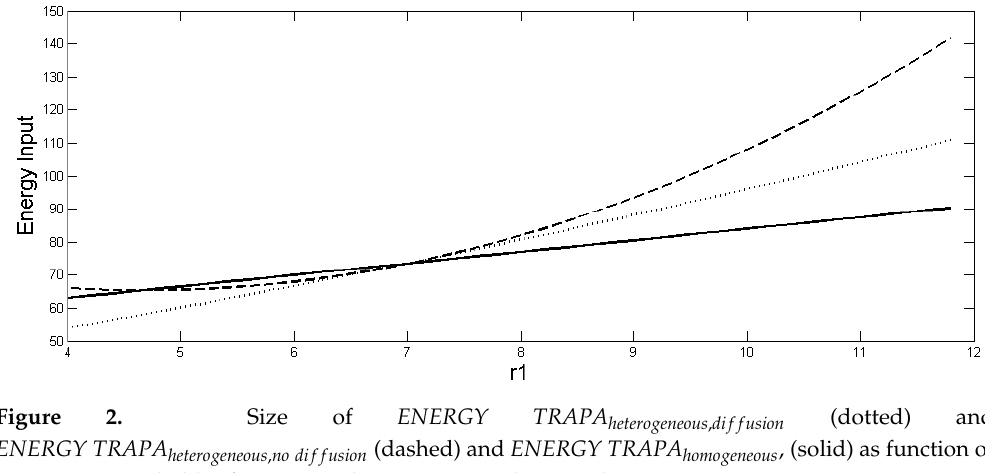
TRAPA (dotted) and TRAPA and Figure 1. Size of , heterogeneous diffusion , heterogeneous no diffusion TRAPA , (solid, overlapping) as function of r 1 . The ratio r 1 / K 1 > r 2 / K 2 holds after r 1 > 7. The homogeneous other parameter values are r 2 = 3.5, K 1 = 14, and K 2 = 7.